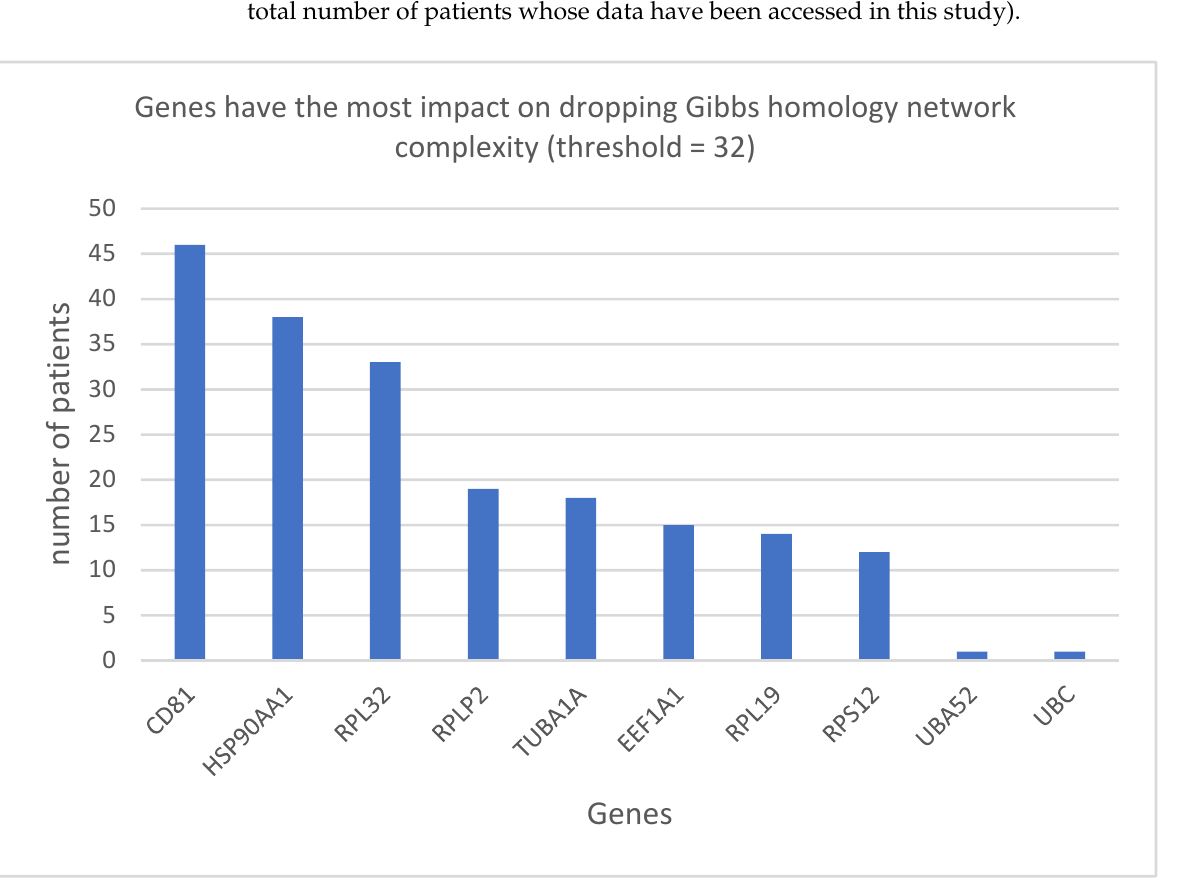
Figure 2. Genes having the most impact on dropping Gibbs homology network complexity (threshold = 32), with counts corresponding to the number of patients having the particular gene as target.